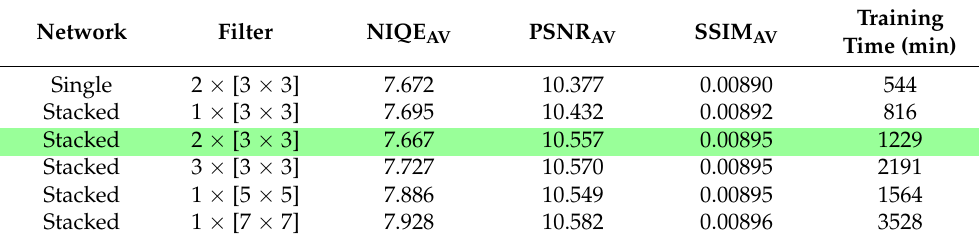
Table 1. Quality scores between various network setting on 300 training epochs.